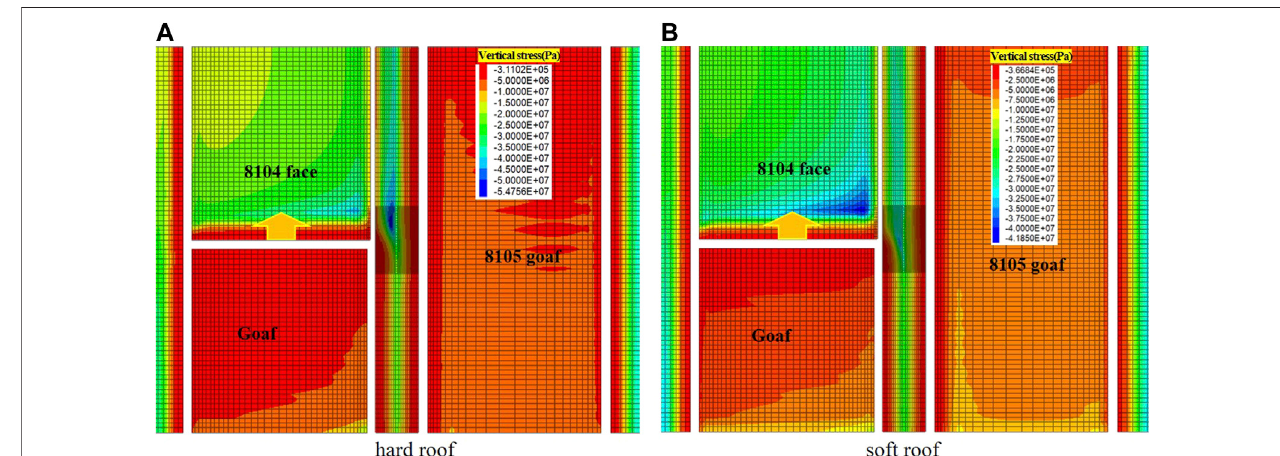
FIGURE 6 | Vertical stress distribution after secondary mining under different roof strength